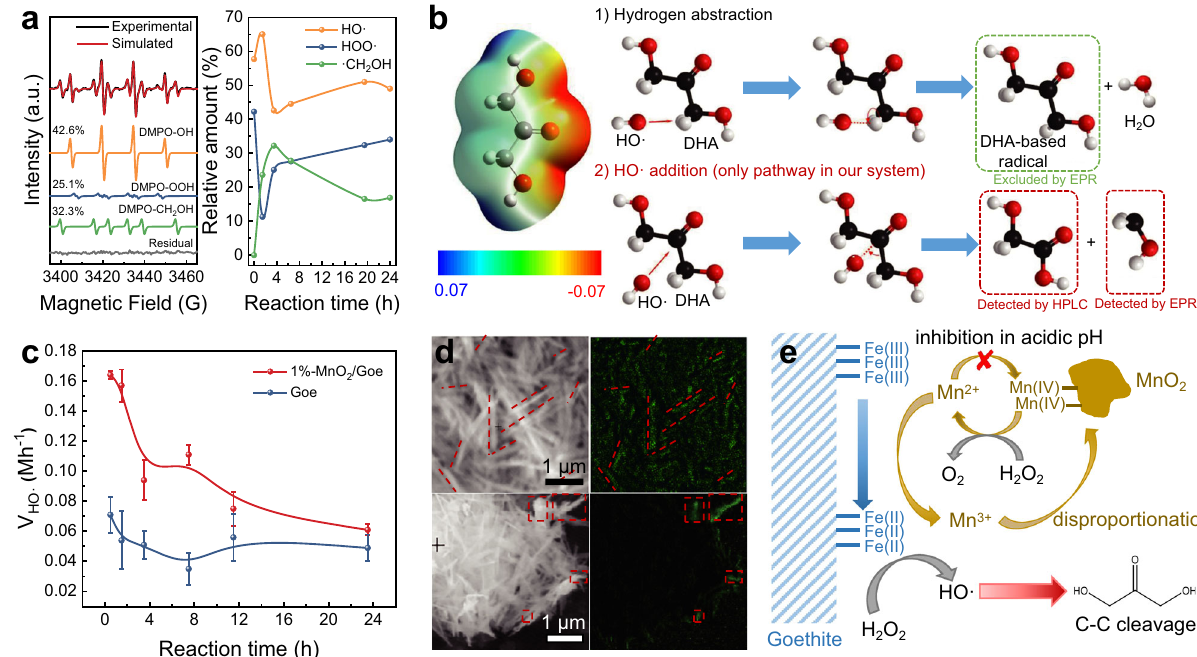
Fig. 4 C − C bond cleavage behavior of DHA molecule. a EPR signals of the DMPO adducts (3.5 h) and relative amount of the DMPO-X adducts over time after adding DHA to the 1%-MnO 2 /Goe system (Hfs parameters: A N = 15.1, A H = 14.8 G for ·OH, A N = 14.3, A ßH = 11.4, A γ H = 1.2 G for ·OOH, and A N = 16.0, A H = 22.8 G for ·CH 2 OH). b Optimized structure and electrostatic potential distribution of DHA (the red surface corresponds to a negative region, whereas the blue surface corresponds to a positive region. Gray, red, and white spheres represent C, O, and H, respectively) and possible reaction pathways for the attack of HO· to DHA. c HO· formation rate over time in pure Goe and 1%-MnO 2 /Goe systems. Error bars represent standard deviations from triplicate experiments. d Scanning Auger mapping of Mn of fresh (bottom) and used (top) MnO 2 /Goe catalyst. e Scheme of the MnO 2 -involved HO· formation mechanism on goethite